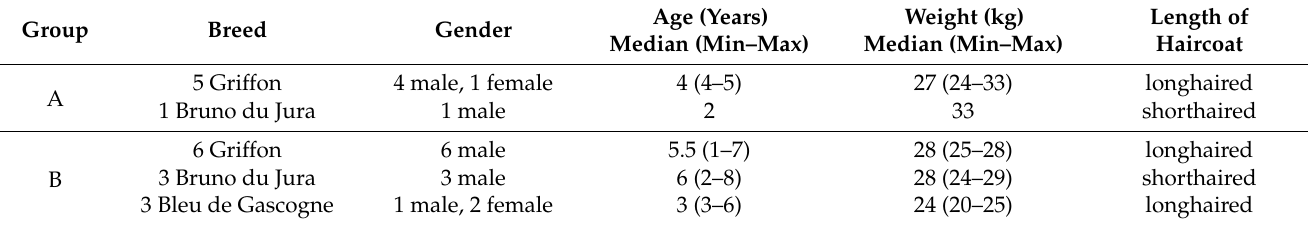
Table 2. Details of the distribution of the animals between the two groups of dogs with